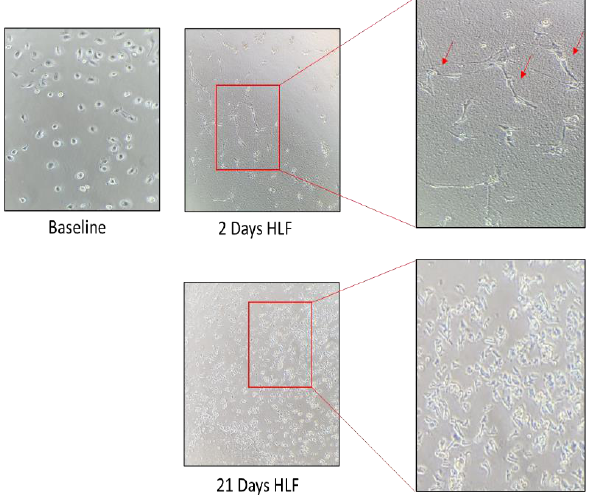
Figure 2. The inverted microscope were used for photo at time 0, 14, 21 and 28 days of cell cultures in both, RPMI and FBM experiments. At any timepoint, the number of cells were counted.